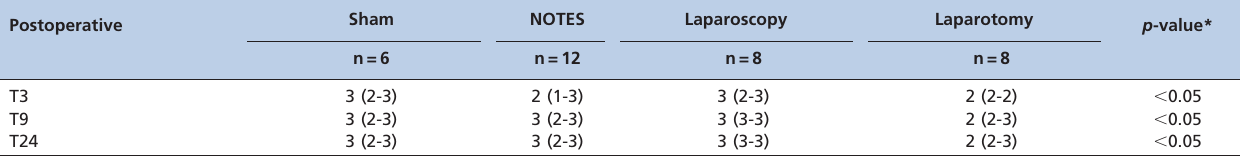
Table 2 - Postoperative recovery